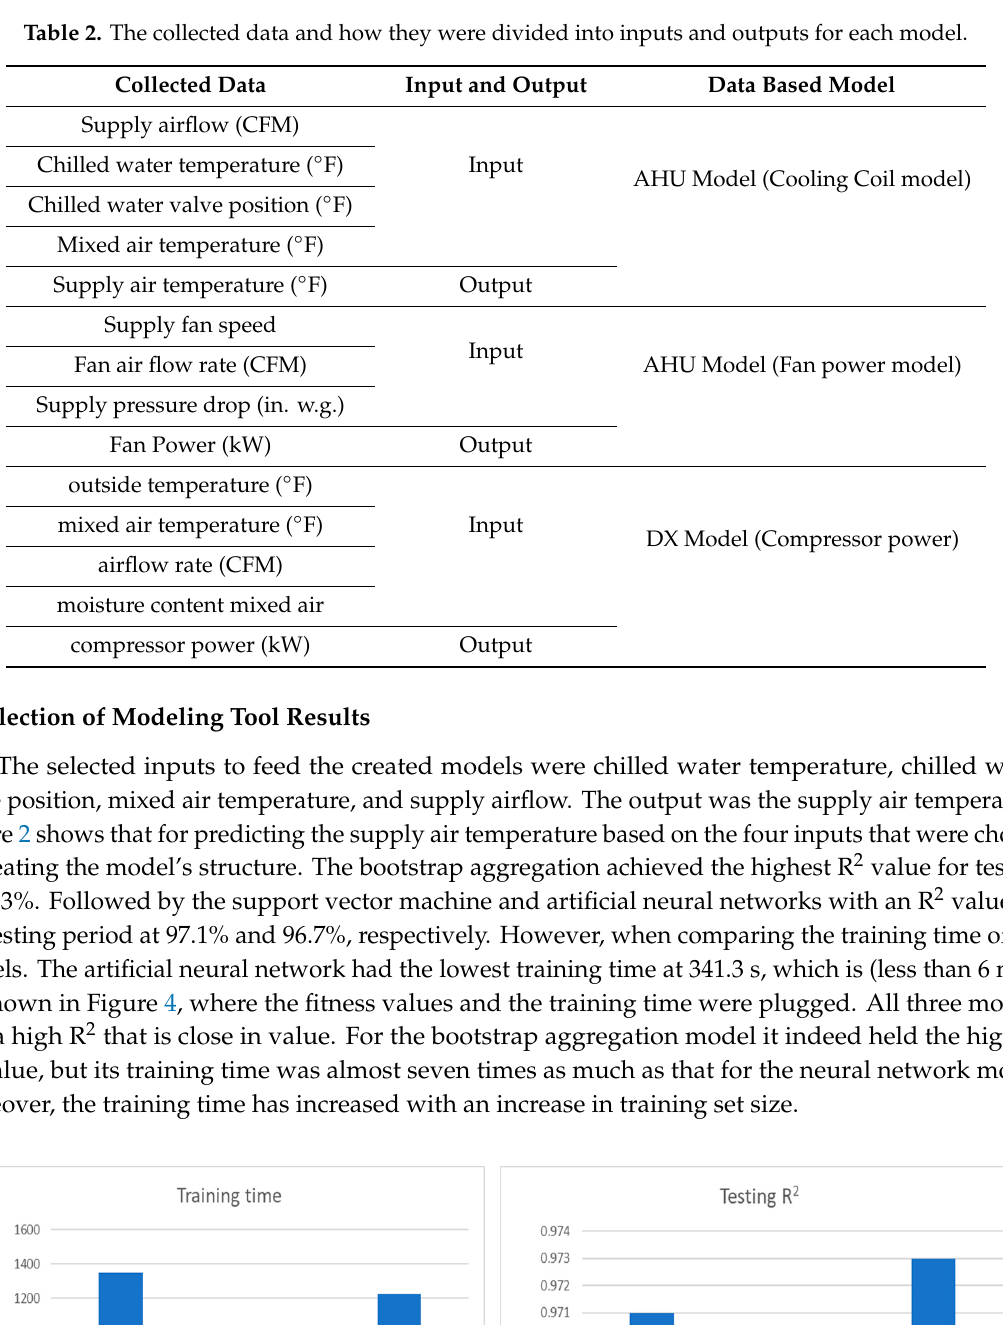
Table 2. The collected data and how they were divided into inputs and outputs for each model. Collected Data